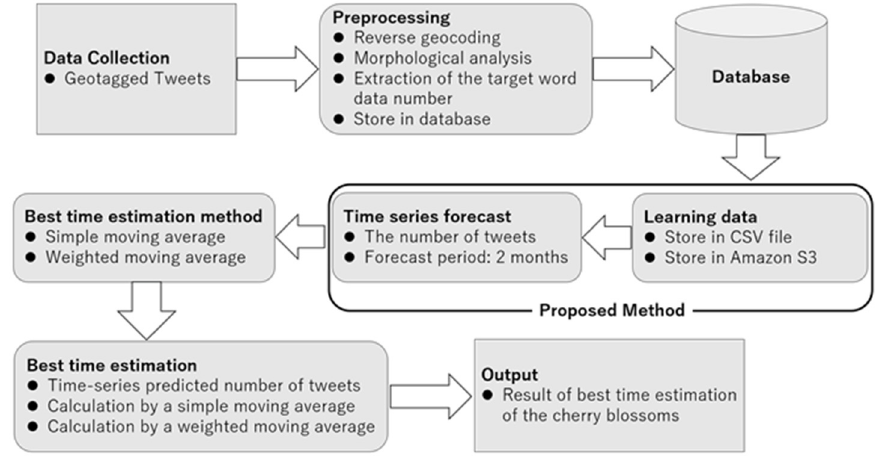
Figure 1. Schematic diagram.